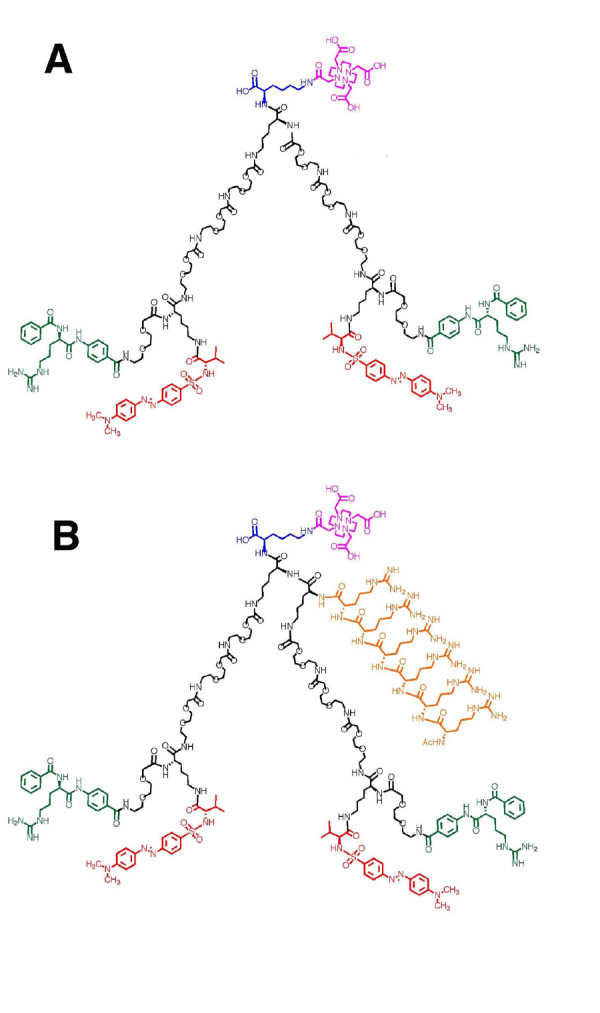
Chemical structures of the dimeric SHAL (DvLPBaPPP)2LLDo (A) and the hexa-arginine analog (DvLPBaPPP)2LArg6AcLLDo (B).